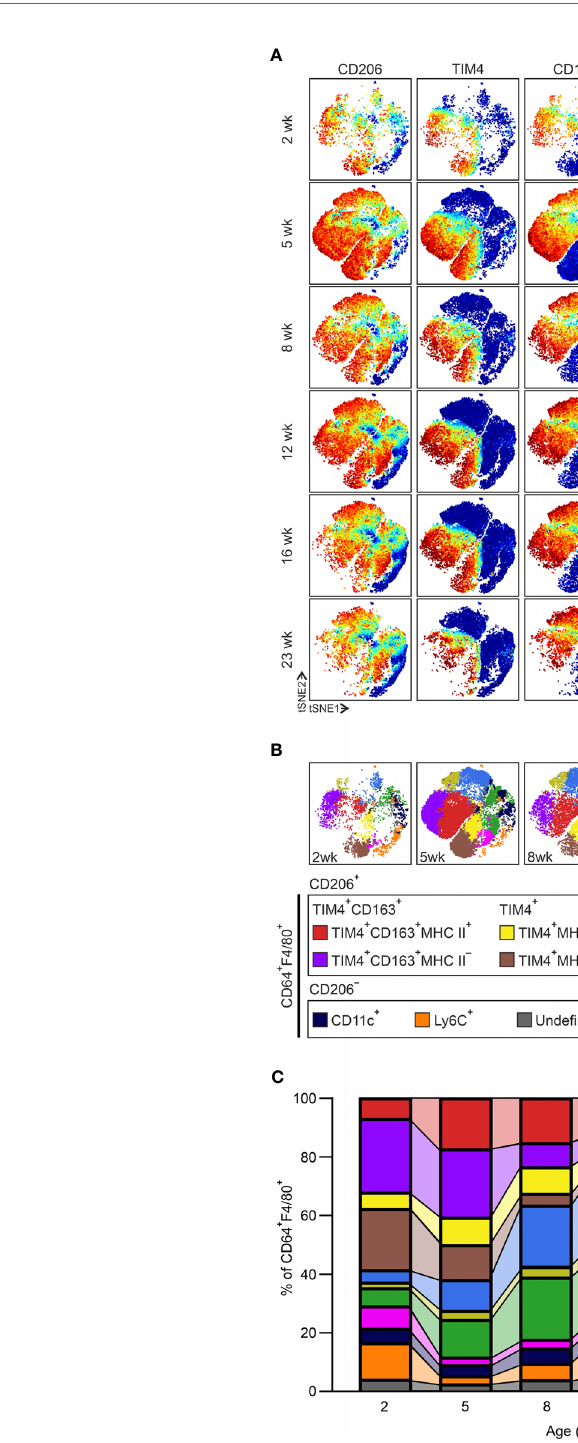
FIGURE 1 | Adipose tissue macrophages (ATMs) evolve during postnatal development. (A) Representative viSNE plots of CD45 + CD64 + F4/80 + macrophages of epididymal white adipose tissue (eWAT) in 2-, 5-, 8-, 12-, 16- and 23-week-old wild-type (WT) mice. The color code indicates the expression level of a given marker from low (blue) to high (red). (B) Representative unsupervised FlowSOM analysis of eWAT CD45 + CD64 + F4/80 + macrophage cell clusters at the indicated time points. Each FlowSOM metacluster (subpopulations) is indicated in different colors. (C) Frequencies of the macrophage subpopulations in WT eWAT based on the FlowSOM analyses at the indicated time points. Each FlowSOM metacluster (subpopulation) is represented by an individual color depicted in the columns (from B ). Data are from n = 14 (2 wk), 12 (5 wk), n = 6 (8, 12, and 16) or n = 8 (23 wk)